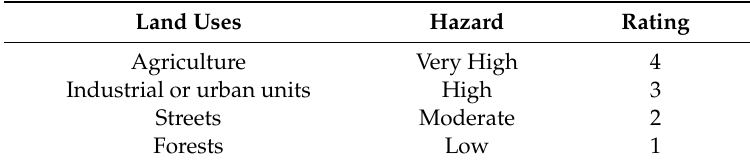
Table 1. Land use ratings for the Hazard map (adapted from Kazakis et al. [9]). Land